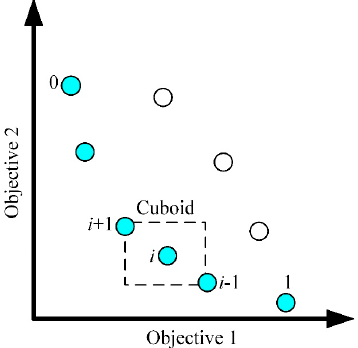
Figure 7. Calculation of crowded distance.